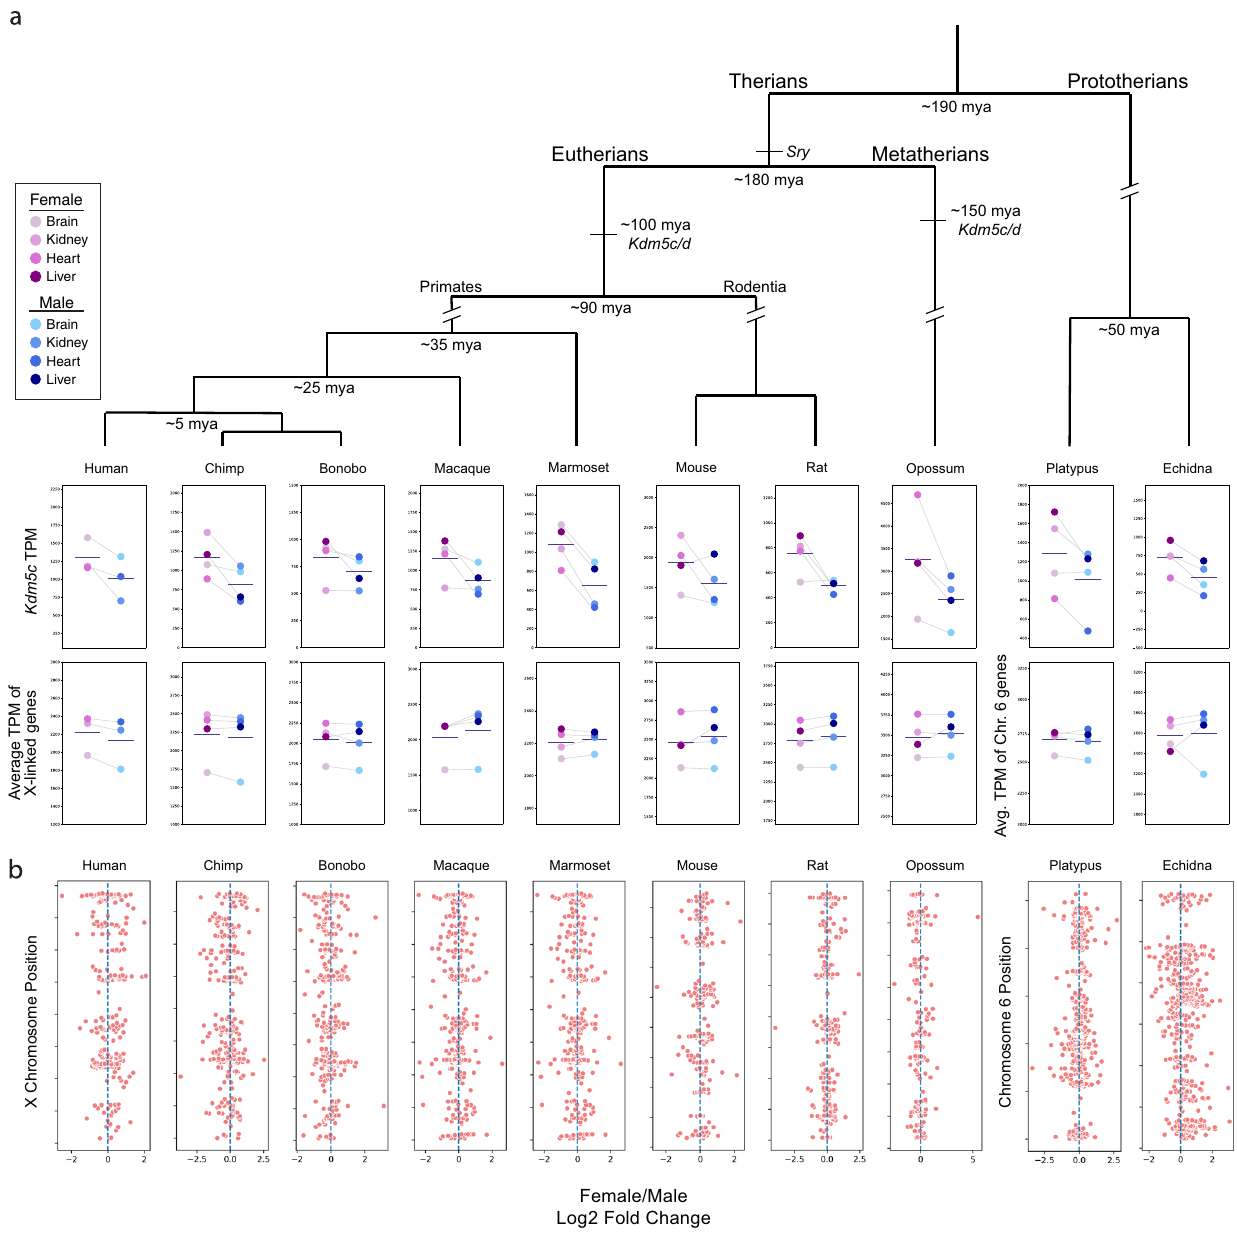
Fig. 6 Phylogeny of Kdm5c/d and increased expression of Kdm5c in females vs. males in therian mammals. a Inferred phylogeny of Kdm5c/d during mammalian evolution 6,7,73 . Top row, Kdm5c transcript per million (TPM) levels in four tissues, as indicated, in females vs. males for seven eutherian species, one metatherian (marsupial) species (opossum), and two prototherian (monotreme) species (platypus and echidna). Bottom row, average TPM of all X-linked genes in females vs. males in the same tissues analyzed for Kdm5c expression. Platypus and echidna TPM averages are from Chromosome (Chr) 6, where KDM5C maps in those species 73 . The dark gray horizontal line in all plots represents the mean of all tissues. Light gray lines connect corresponding tissue types between males and females. b Distribution of female:male expression of genes across the therian X chromosome or monotreme Chr 6. Each dot is the log2 fold change of a gene ’ s expression in females vs males and was calculated from the average of that gene ’ s TPM in the brain, heart, kidney, and liver; human plot includes expression from the brain, heart, and kidney. See Supplementary Data 1 – 12 for sequencing data from each